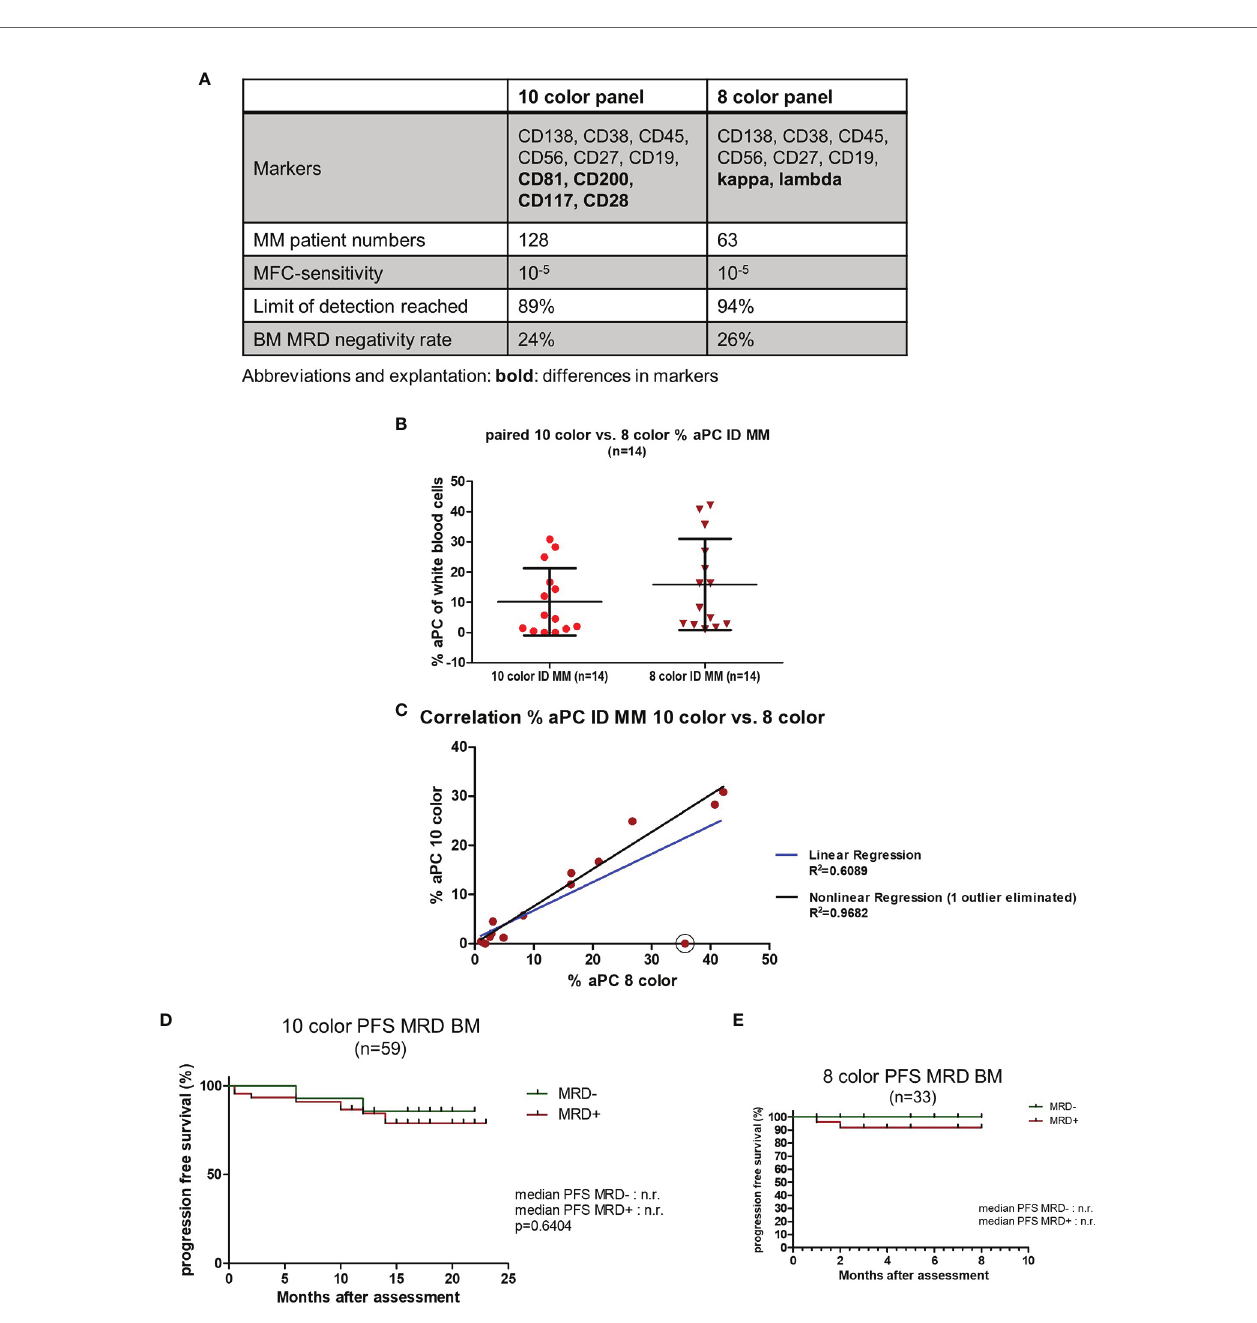
FIGURE 4 | Comparison with 8-color MFC panel including kappa/lambda. (A) Comparison of the 10-color panel with the previously established 8-color panel including kappa/lambda. Markers, number of assessed samples, sensitivity, percentage of samples that reached the limit of detection (LOD), and BM negativity rate were compared. (B) Comparison of aPC percentage in paired 10-color and 8-color ID MM samples (n = 14). (C) Correlation analysis of aPC percentage measured via the 10-color and 8-color panel in 14 paired ID MM BM samples. Linear regression in blue (R 2 = 0.6089) and nonlinear regression eliminating one outlier (circled) in black (R 2 = 0.9682). (D) Kaplan-Meier analysis of progression-free survival in the 10-color BM MRD cohort for MRD- vs. MRD+ patients (n = 59). (E) Kaplan-Meier analysis of progression-free survival in the 8-color BM MRD cohort for MRD- vs. MRD+ patients (n =